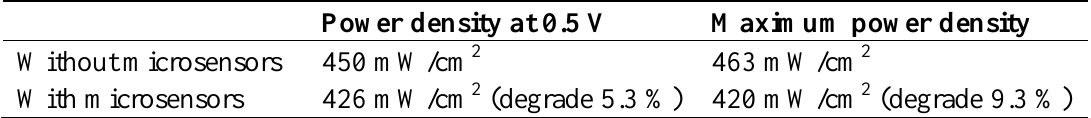
Table 3. Comparison of power density with and without the